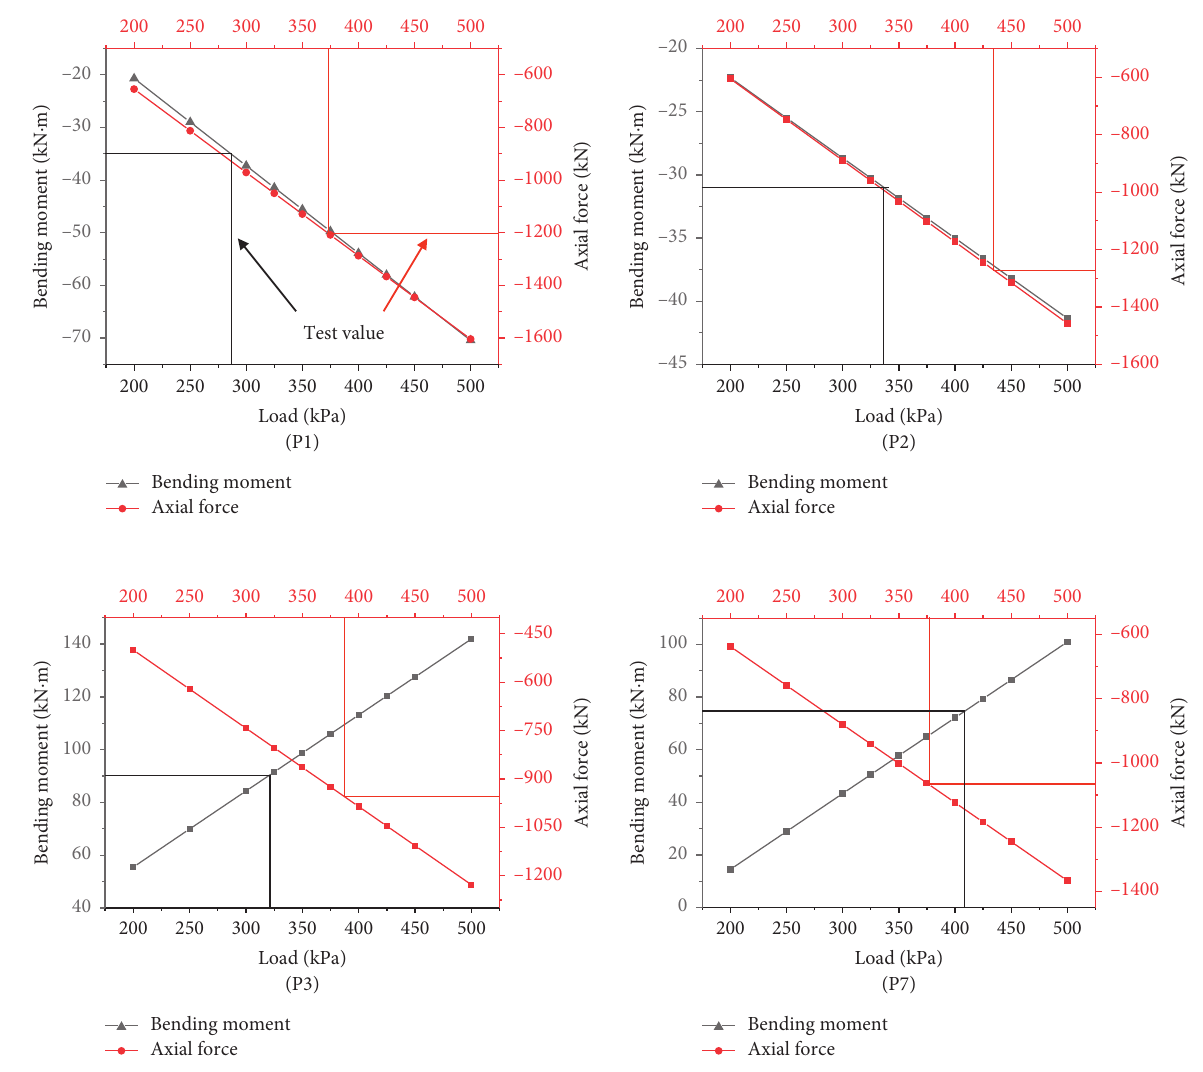
Figure 11: Comparison of the internal force curves between the test point values and the load